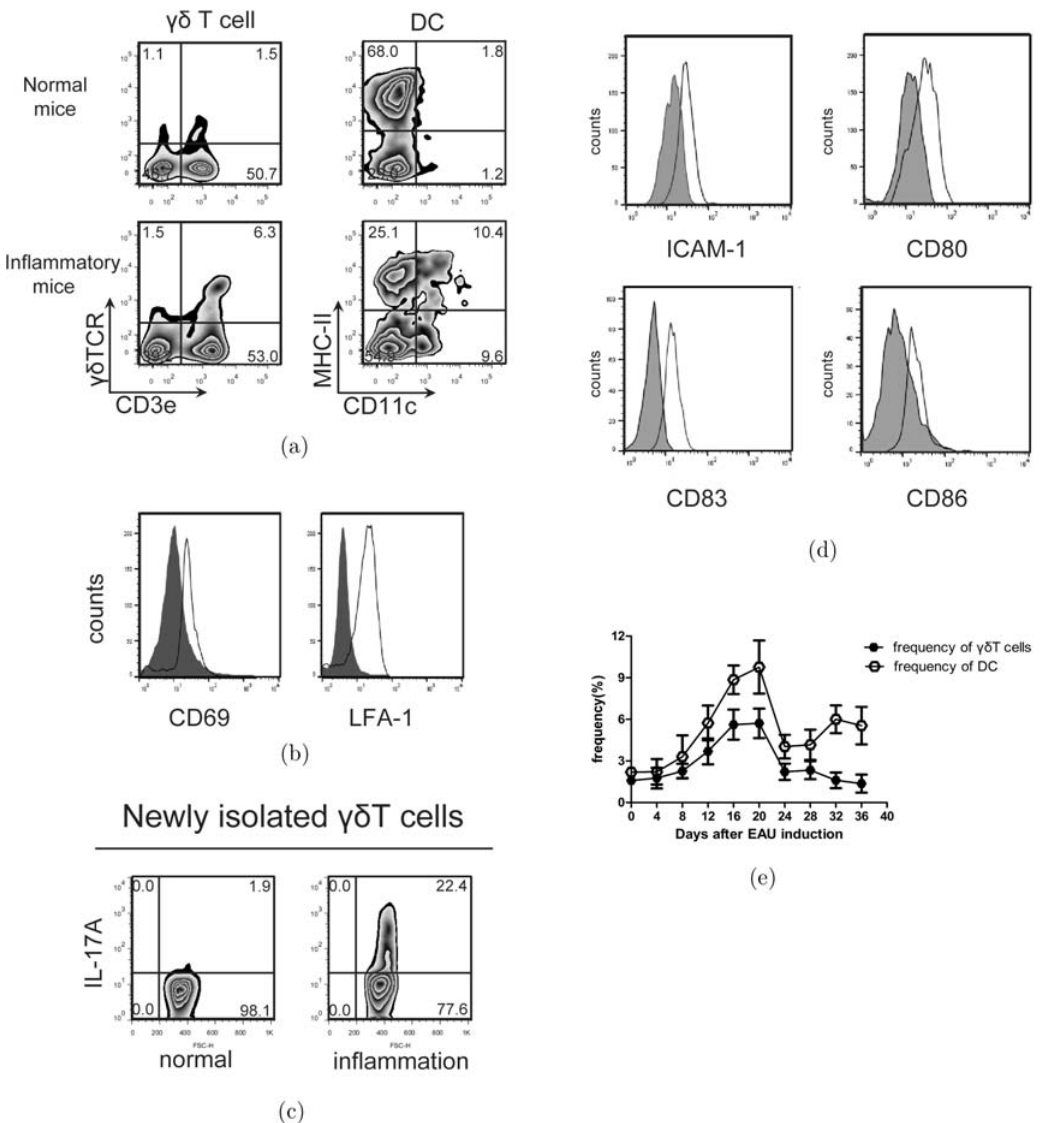
Fig. 2. The status of (cid:1)(cid:2) T cells and DCs obtained from the spleens of immunized mice in the in°ammatory phase, as analyzed using °ow cytometry. (a) The changes in the percentage of (cid:1)(cid:2) T cells among splenic T-cells are shown in the left column. T-cells are stained with PE-conjugated (cid:1)(cid:2) TCR and APC-conjugated CD3e antibodies. T-cells that coexpressed (cid:1)(cid:2) TCR and CD3e are (cid:1)(cid:2) T cells. The changes in the percentage of DCs among lymphocyte cells isolated from the spleens of mice are shown in the right column. (b) The expression of CD69 and LFA-1 in the (cid:1)(cid:2) T cells obtained from the spleens of normal mice (shadow line) compared with the expression in cells obtained from the spleens of mice with severe in°ammatory symptoms (solid line). (c) The level of IL-17A in (cid:1)(cid:2) T cells obtained from the spleens of normal mice (left panel) and mice with severe in°ammatory symptoms (right panel). (d) The expression of ICAM-1, CD80, CD86, and CD83 in DCs obtained from the spleens of normal mice (shadow line) compared with the expression in cells obtained from the spleens of immunized mice with severe in°ammatory symptoms (solid line). (e) Changes in the percentages of (cid:1)(cid:2) T cells and DCs obtained from the spleens of diseased mice on days 0, 4, 8, 12, 16, 20, 24, 28, 32, and 36 after